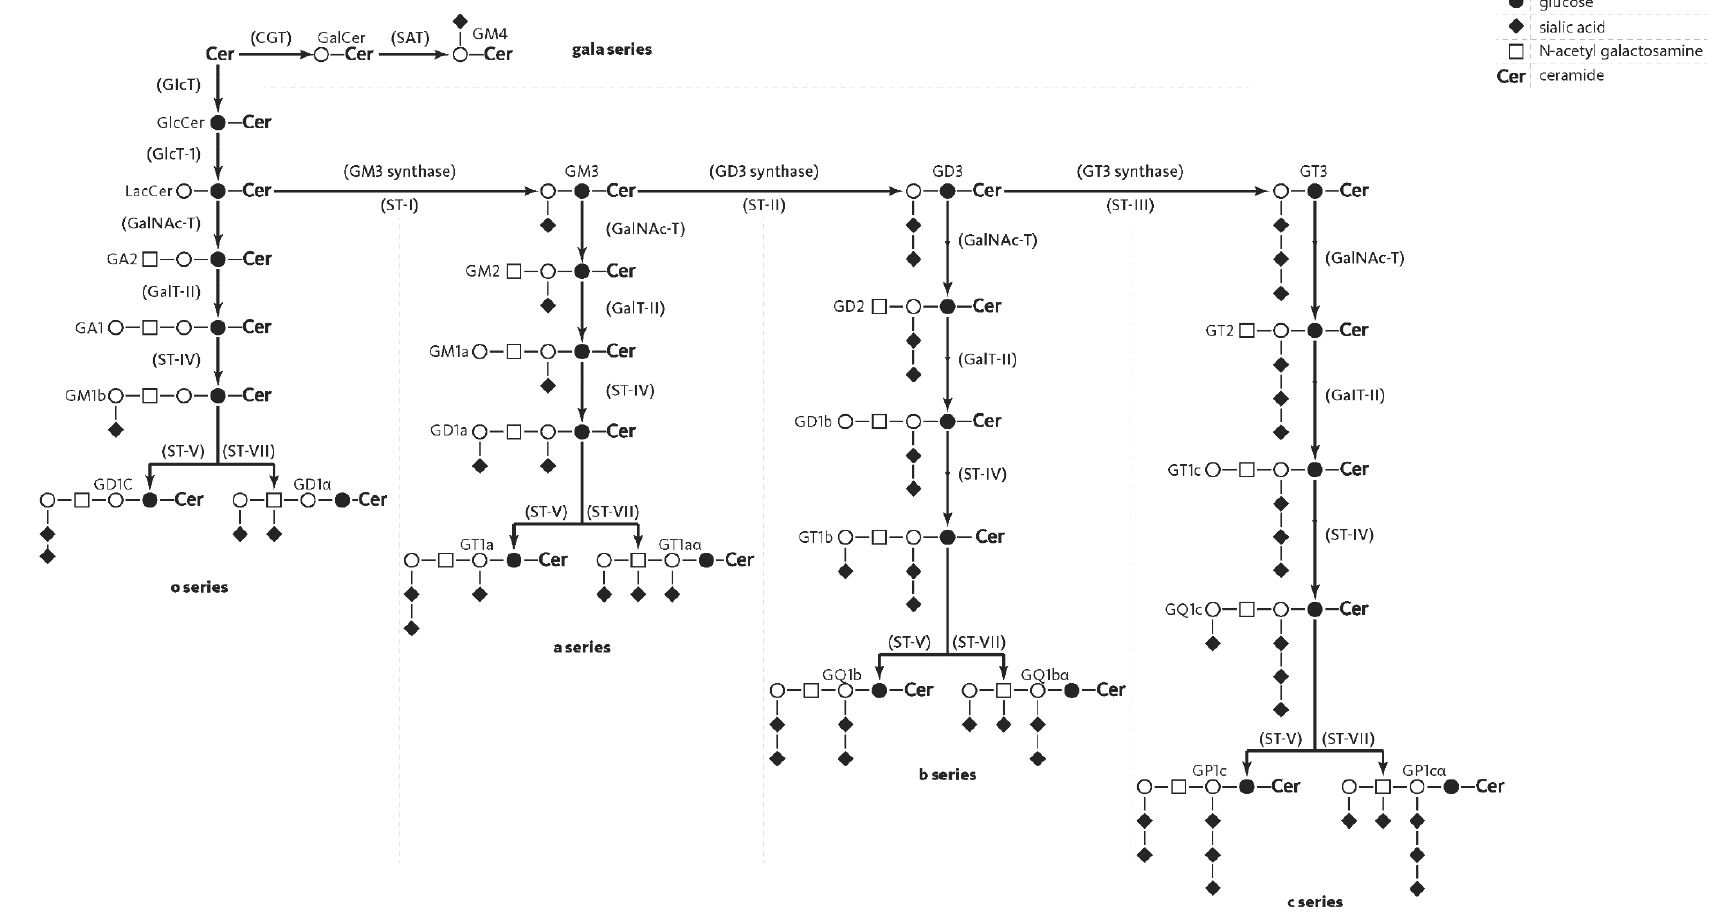
Figure 1. Biosynthetic pathways and nomenclature of major brain gangliosides. The gangliosides are synthesised sequentially by a series of glycosyl and sialyl (S) transferases